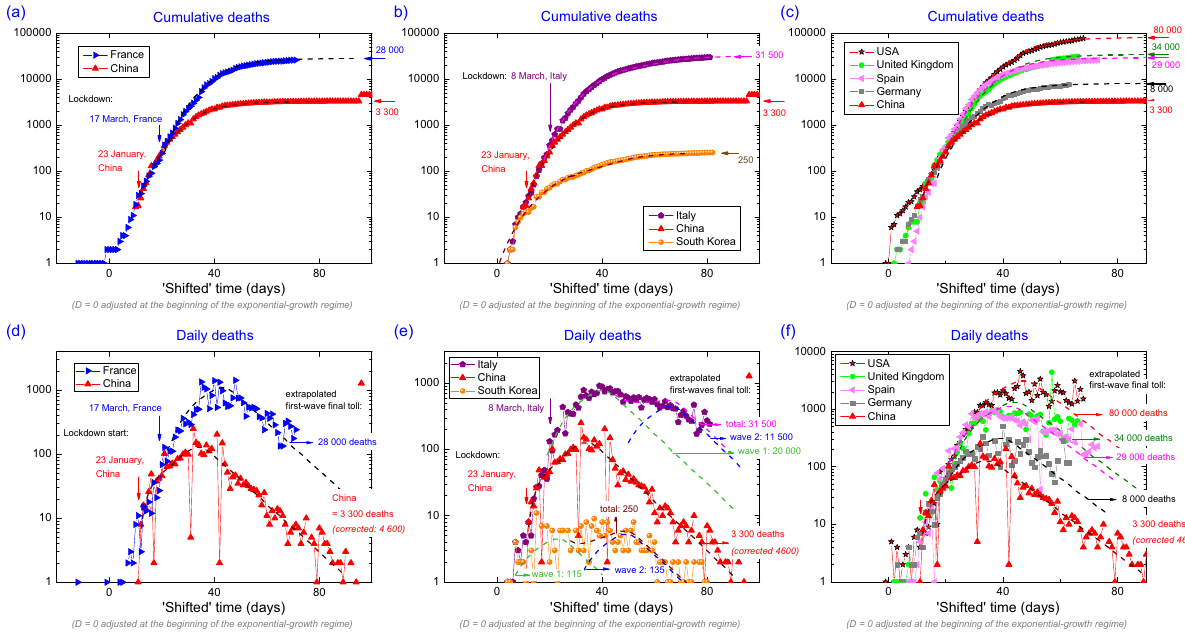
Figure 5. Extrapolation of (a) cumulative and (d) daily death numbers in France, assuming a unique wave similar to that reported in China. Extrapolation of (b) cumulative and (e) daily death numbers in Italy and South Korea, assuming two successive epidemic waves, each one being similar that reported in China. Extrapolation of (c) cumulative and (f) daily death numbers in the USA, UK, Spain and Germany, assuming a unique wave similar to that reported in